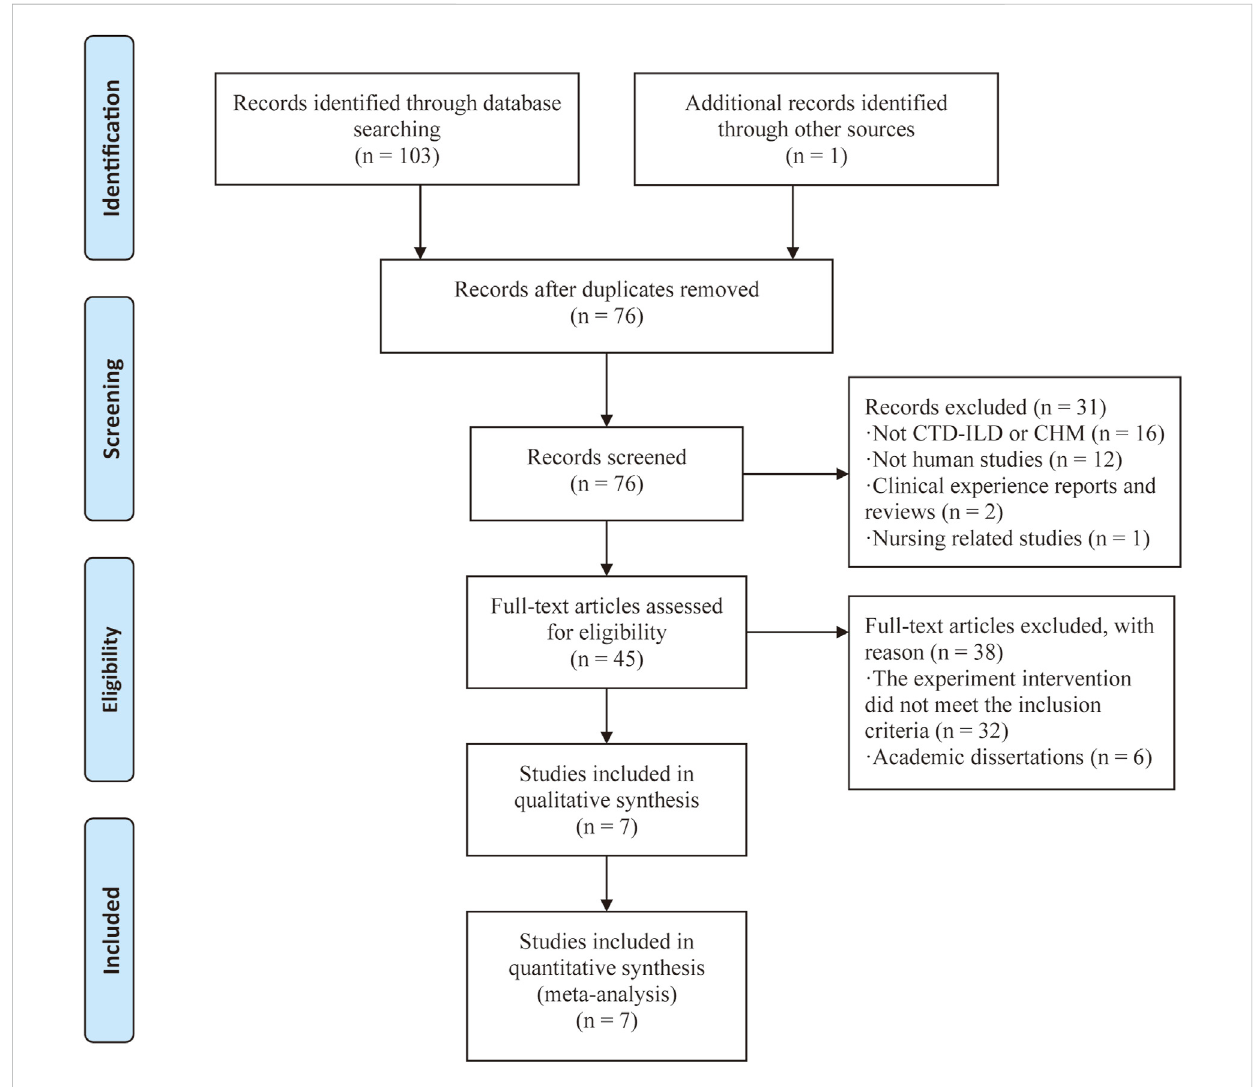
FIGURE 1 Study selection fl ow